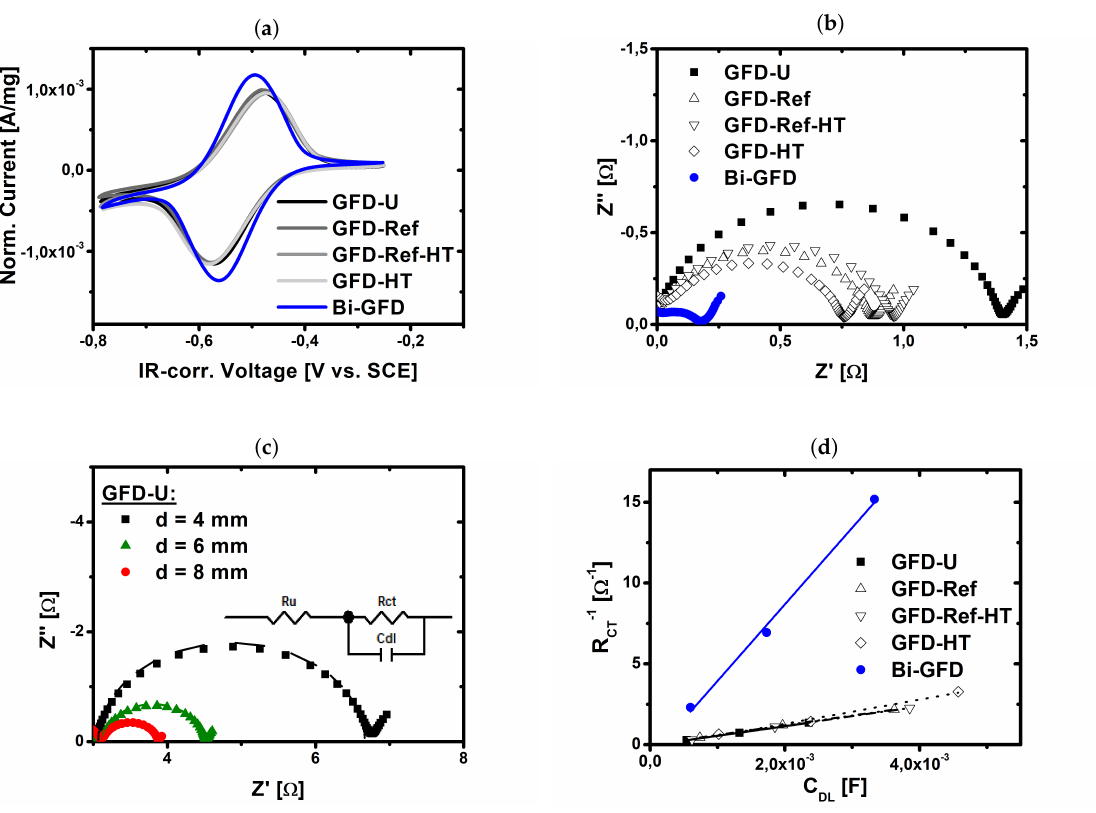
Figure 2. Measurements in three-electrode setup using differently modified carbon felt electrodes: ( a ) IR-corrected CV curves, given currents normalized by electrode weight; ( b ) Nyquist plots of modified carbon felts; ( c ) exemplary Nyquist plots of carbon felt with different diameters; ( d ) inverse charge transfer resistance plotted versus double layer